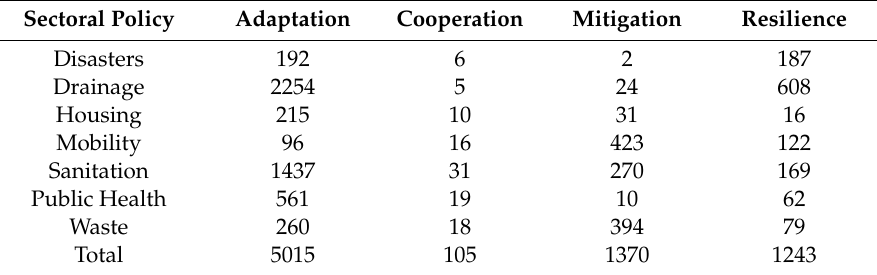
Figure 15. References to health in city sectoral plans. Table 15. Climate action references in sectoral policies.